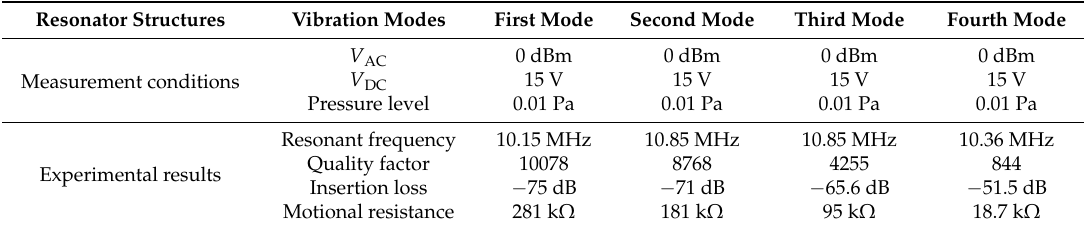
Table 2. Summary of measurement conditions and evaluation results of the first, second, third, and fourth mode capacitive resonators.